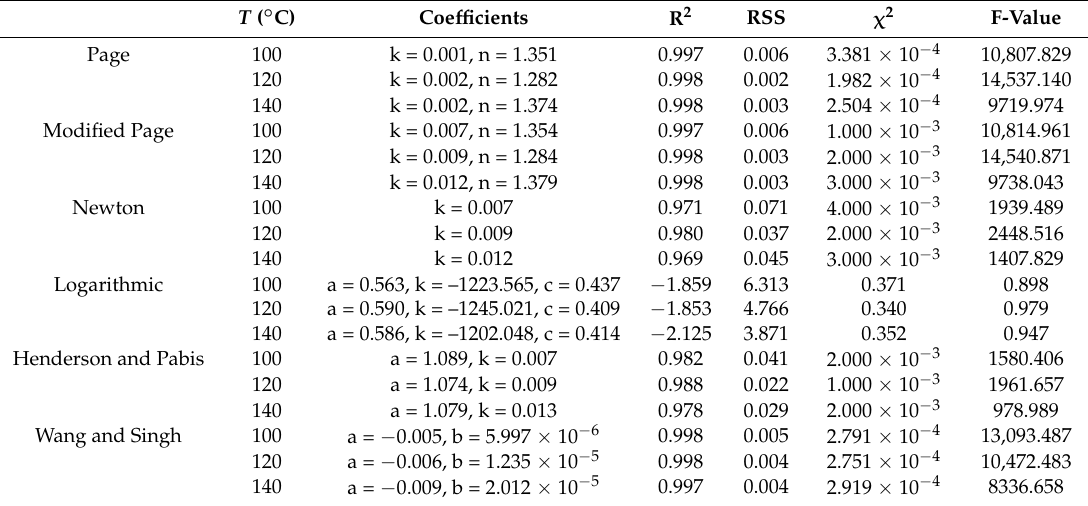
Table 5. Evaluated results of mathematical thin-layer drying models at different